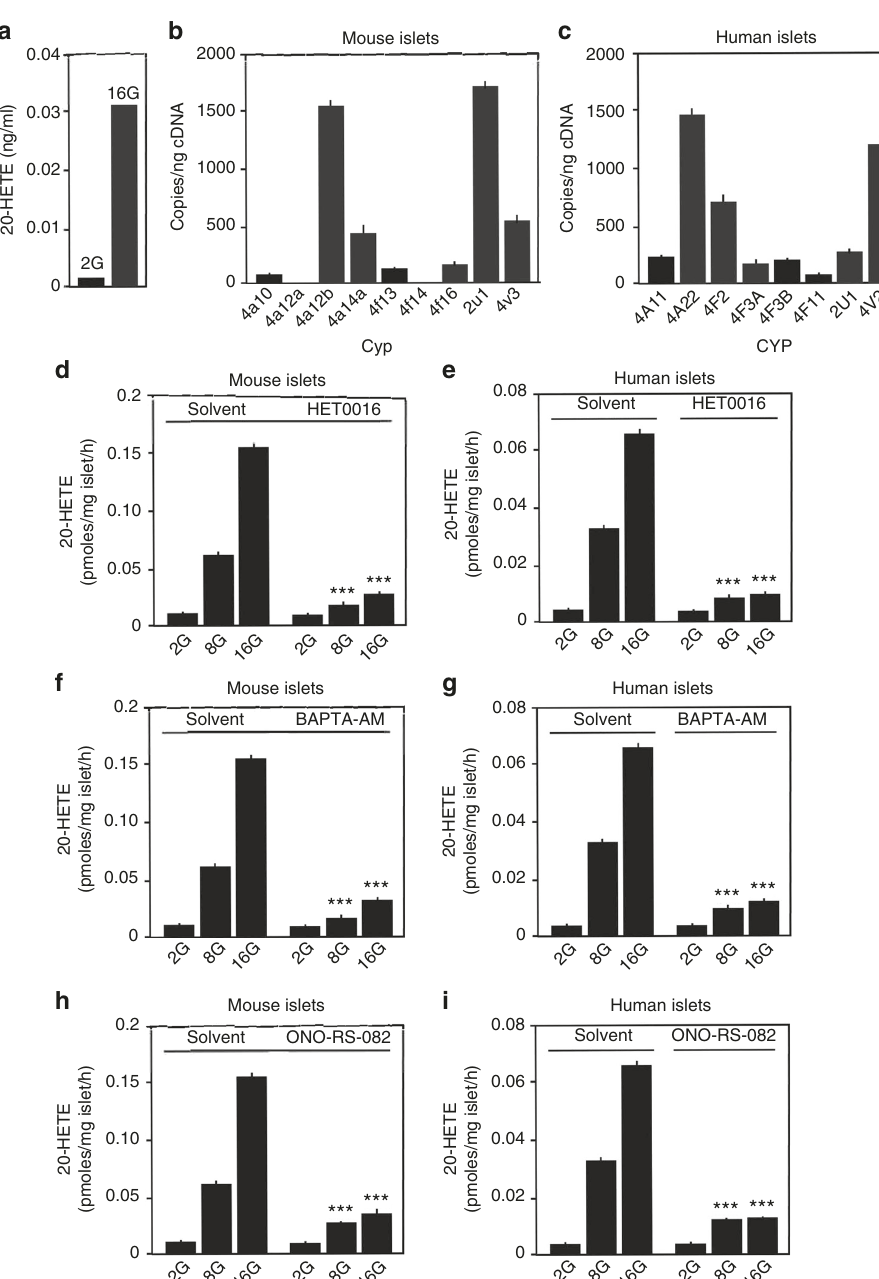
Fig. 3 Glucose induces 20-HETE synthesis and release. a Mass-spectrometric determination of 20-HETE concentration in supernatants from isolated mouse islets incubated for 2 h in HBSS containing 2.8 mM (2G) and 16.7 mM (16G) glucose ( n = 1). b , c Expression of CYP450 ω -hydroxylases involved in 20-HETE synthesis in mouse ( b ) and human pancreatic islets ( c ). d – i Effect of 30 µ M HET0016 ( d , e ), 10 µ M BAPTA-AM ( f , g ), and 30 µ M ONO-RS-082 ( h , i ) on the formation of 20-HETE in mouse ( d , f , h ) and human ( e , g , i ) islets kept in 2.8 (2G), 8.35 (8G), and 16.7 mM (16G) of glucose. Shown are mean values ± s.e.m., n = 3 ( b , c ), n = 9 ( d – i ); ***P ≤ 0.001 (compared to solvent) (Student ’ s two-tailed t -test) cellular FFAR1 activation assays, were unable to compete with than dietary FFAs with regard to the induction of FFAR1- 3 H-palmitic acid (Fig. 1d). Recent data indicate that FFAR1 can mediated effects (Fig. 1a, b). In contrast to 20-HETE, arachidonic not only signal through G q /G 11 but also through G s and β - acid was less active, and 18-HETE as well as 19-HETE showed no arrestin, depending on the ligand 27, 28 . Similar to dietary FFAs, activity on FFAR1 (Fig. 1a, b). The FFAR1 antagonist GW1100 26 concentration-dependently inhibited α -linolenic acid as well as 20-HETE acting through FFAR1 did not lead to activation of G s 20-HETE-induced elevation in [Ca 2+ ] i in cells transfected with (Fig. 1e) but was able to recruit β -arrestin, although with rela- FFAR1 (Fig. 1c), con fi rming that the effect of 20-HETE is tively low potency (Fig. 1f). Interestingly, 20-HETE at 30 μ M had mediated by the receptor. In addition, 20-HETE was able to no activity on FFAR4 (GPR120), a FFA receptor activated by displace 3 H-palmitic acid from the FFAR1 receptor expressed in dietary long-chain fatty acids 29 (Fig. 1g). We conclude that 20- COS-1 cells whereas 18- and 19-HETE, which were inactive in HETE is a speci fi c orthosteric agonist of FFAR1, which shows | DOI: 10.1038/s41467-017-02539-4 |